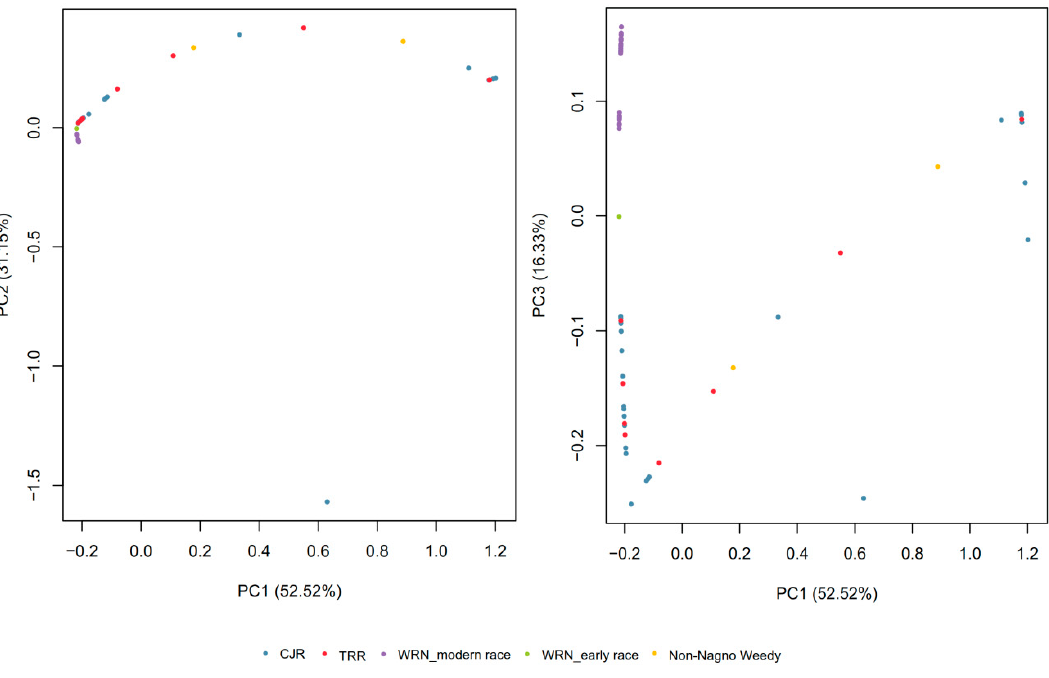
Figure 2. Radiation type of neighbor-joining tree constructed from 50K SNPs. Symbols represent the same samples as described in Figure 1. Note the sub-groups of WRN (open and closed green circles).